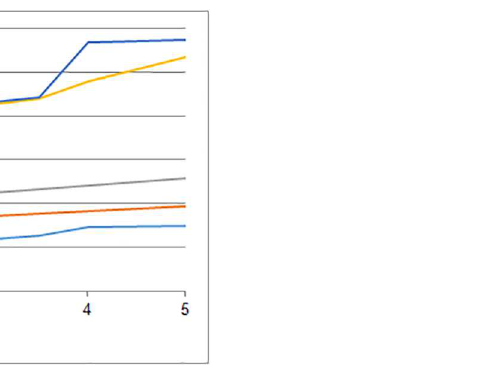
Fig 1. Cost accumulation over time according to stage at diagnosis.